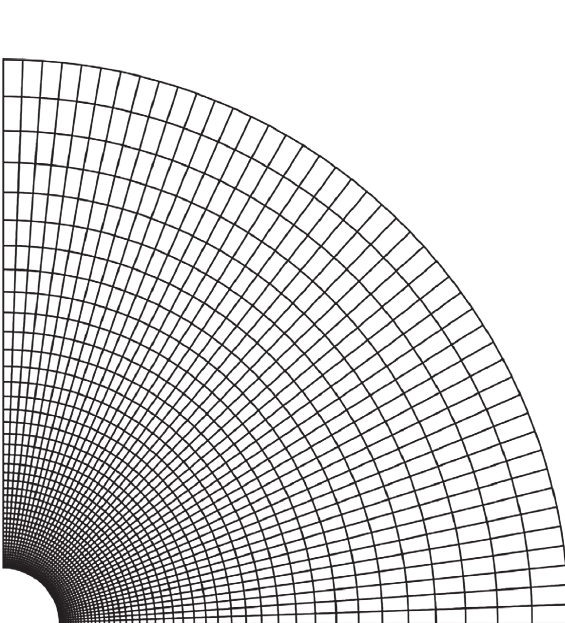
Figure 3: Geometry and boundary conditions for the circular tunnel excavation example.